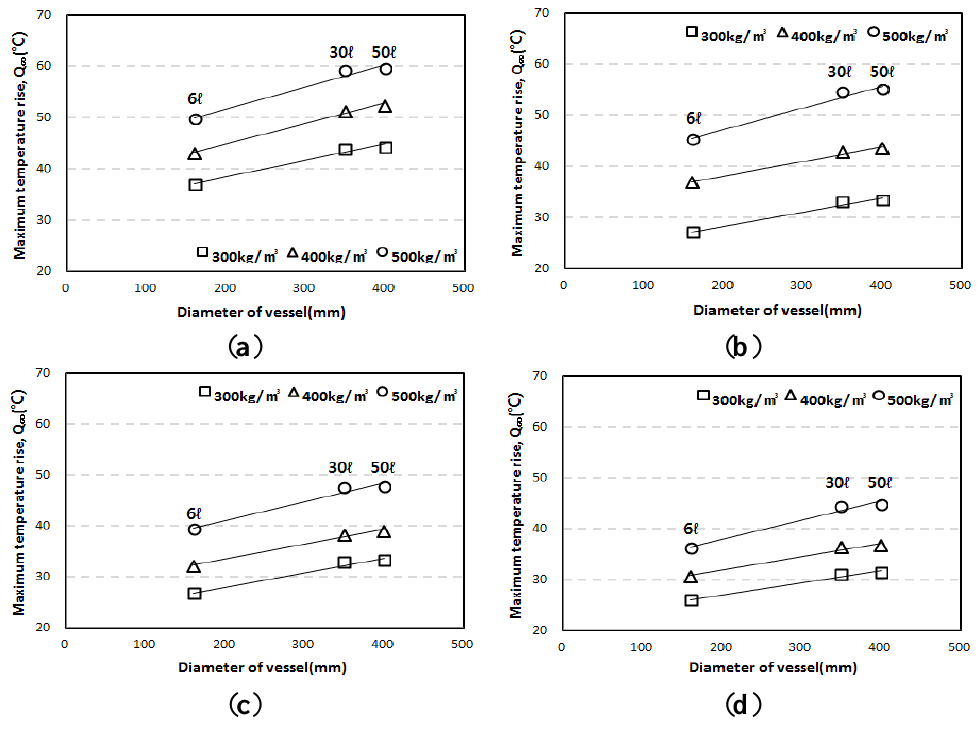
Figure 8. Maximum temperature rise obtained from the 6 L, 30 L, and 50 L specimen tests.